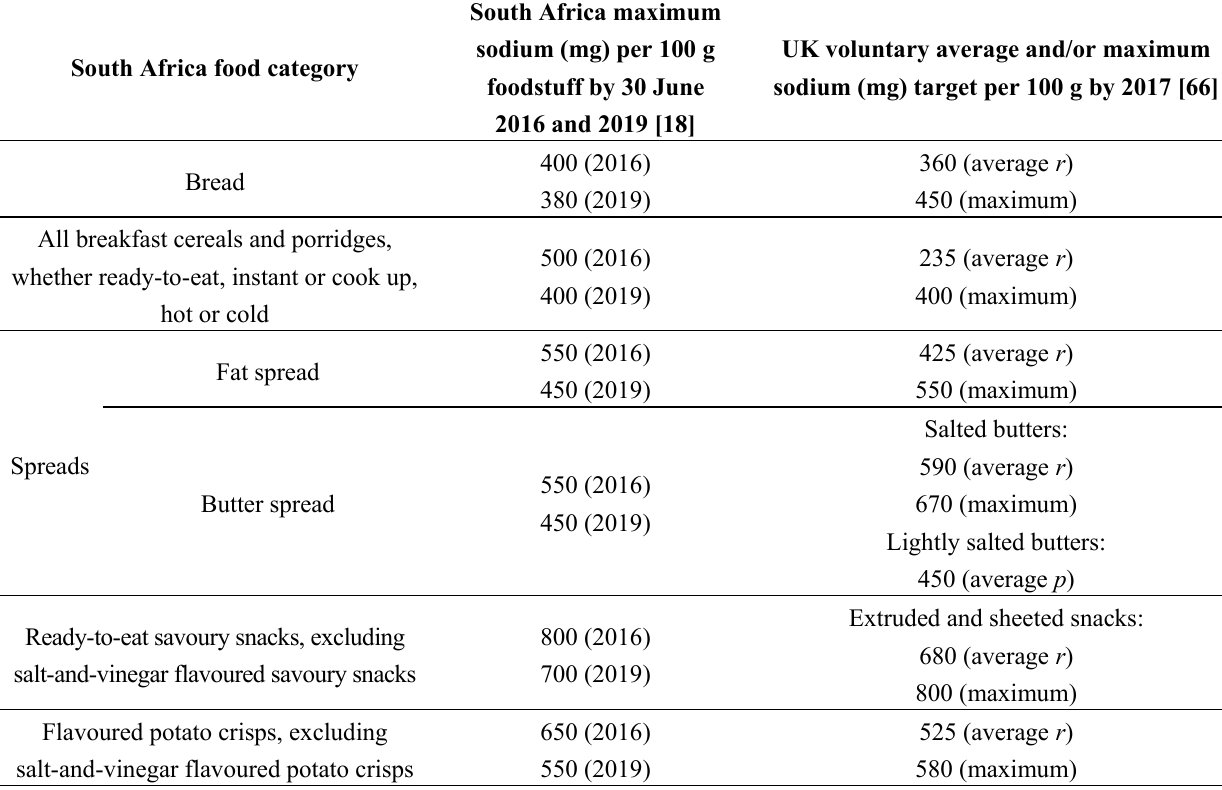
Table 2. Comparison of main salt level targets for processed foods in the UK and South